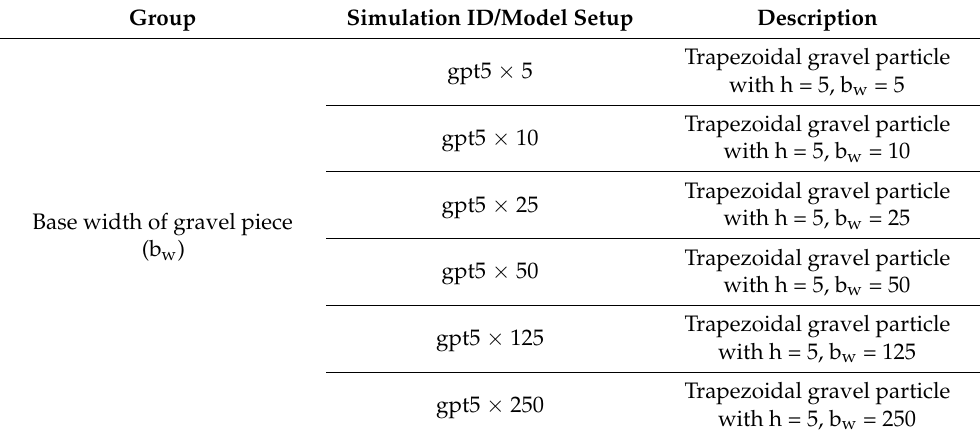
Table 2. Model setups for the analysis of the effect of base width variation over hyporheic exchange. Units are mm.